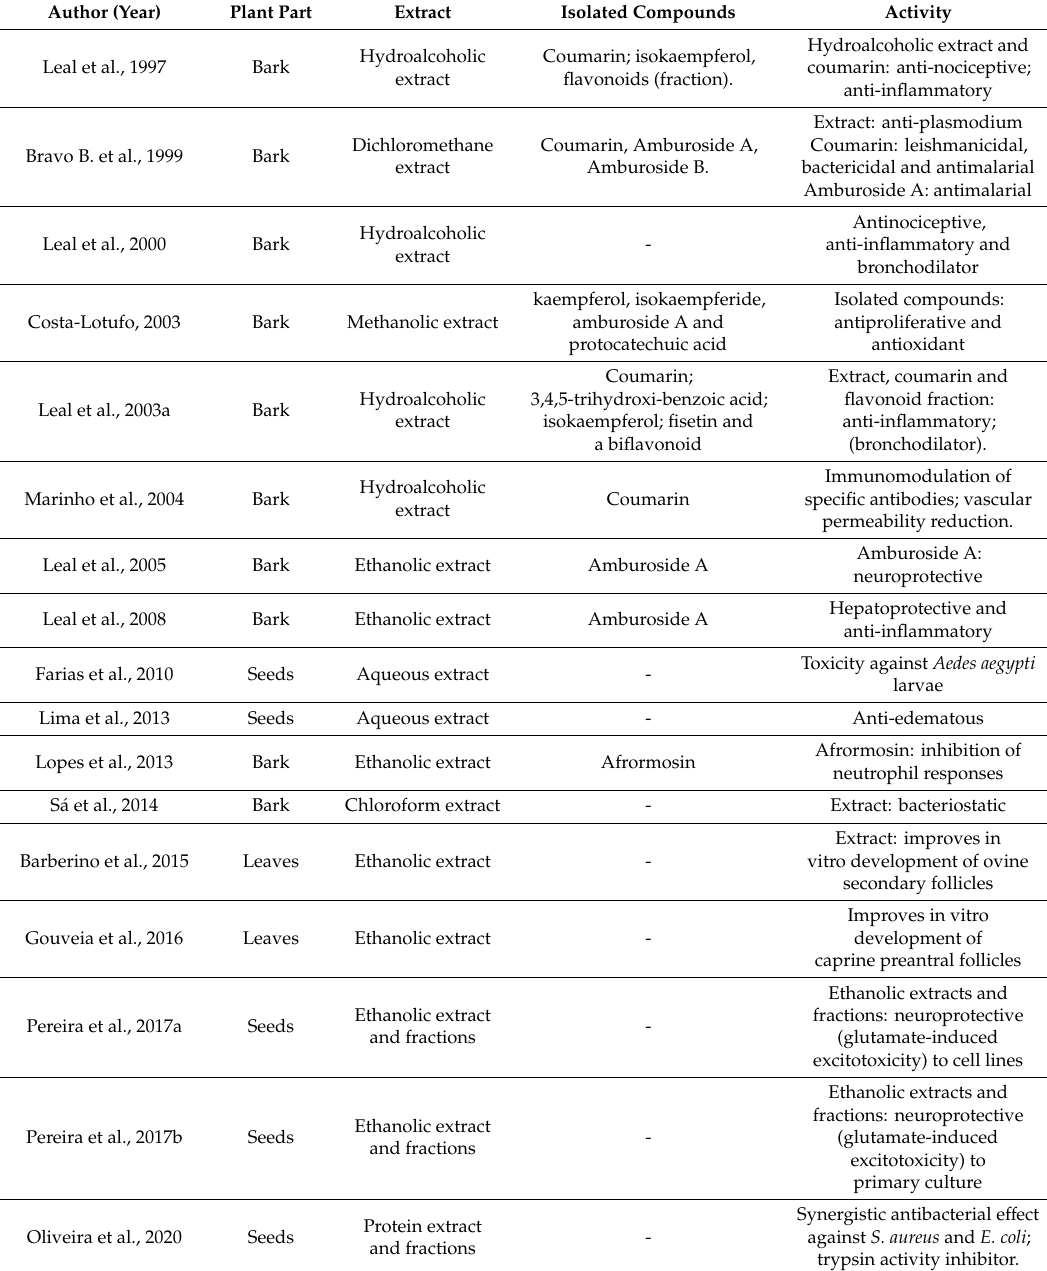
Table 1. Isolatedcompoundsfromdifferentextractsandpartsof A.cearensis